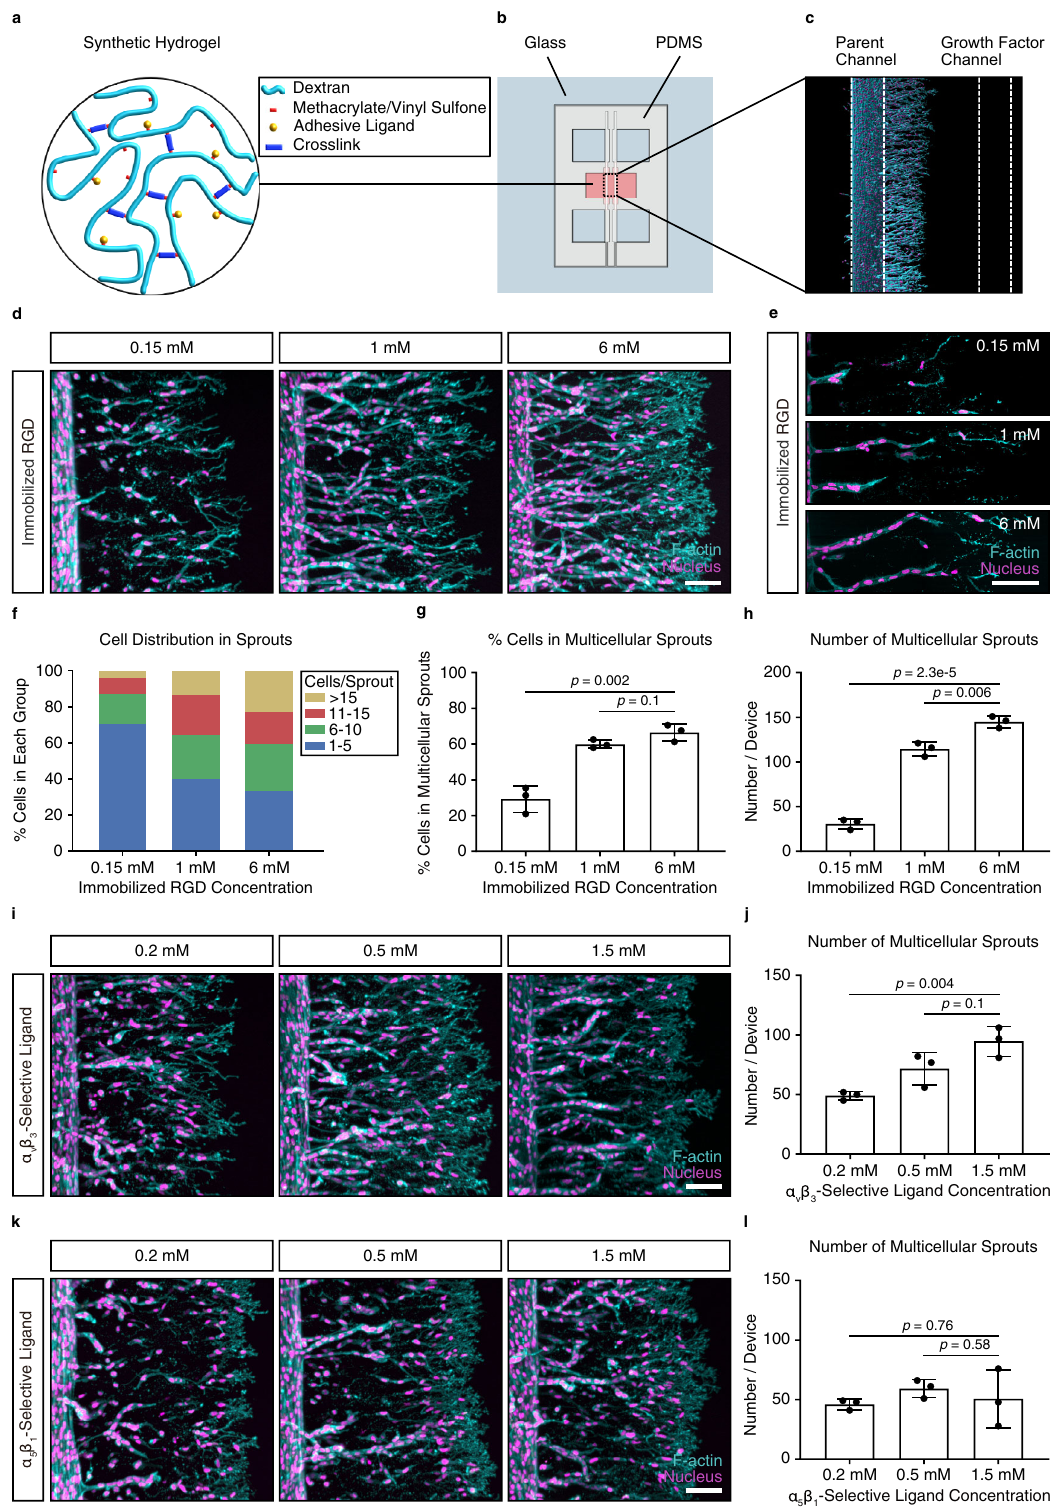
α β α β v 3 , but not 5 1 integrin activation is the main regulator of multicellularity, we allowed HUVECs to invade into matrices functionalized with 6 mM RGD (to engage both integrin types), and inhibited each integrin type individually using soluble cyclic RGD and a soluble α 5 β 1 -speci fi c peptidomimetic ligand. Indeed, inhibiting α v β 3 integrin engagement disrupted collective cell migra- tion, whereas the inhibition of α 5 β 1 integrins did not